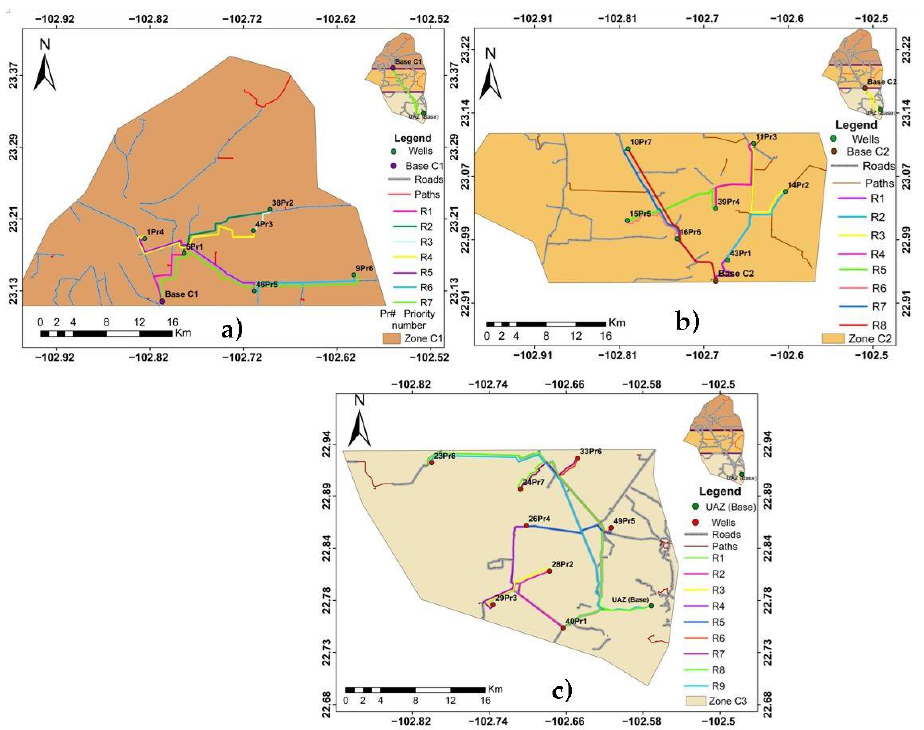
Figure 8. Monitoring wells with their visit priorities for Zone C3; the monitoring route begins and ends at the UAZ (Base).